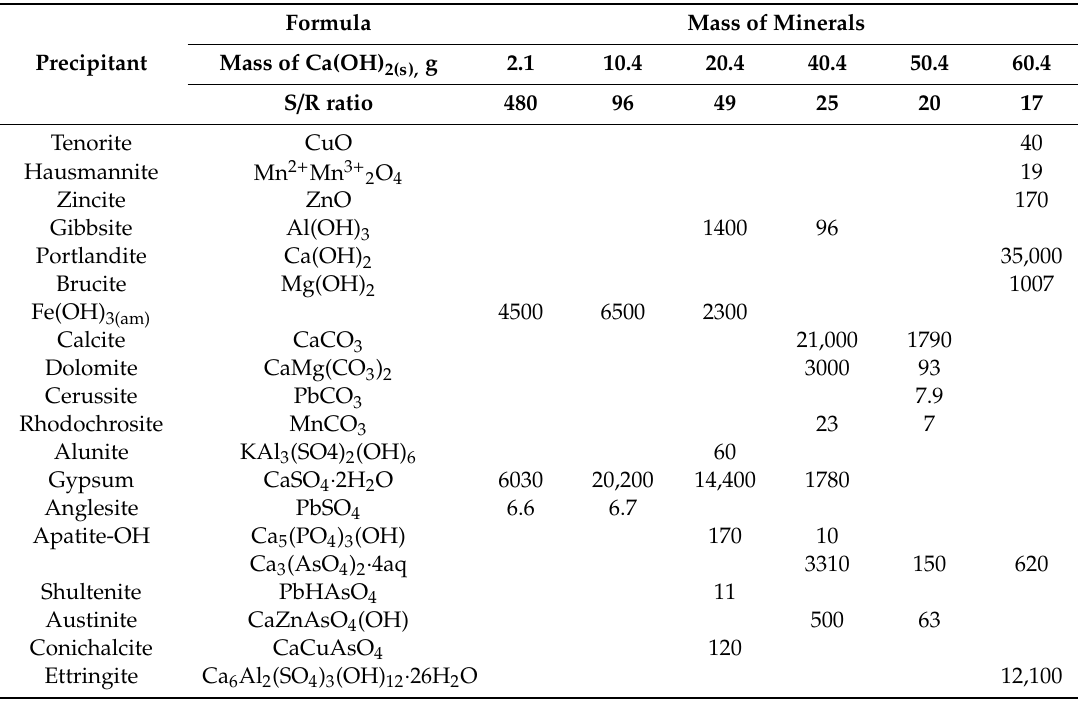
Table 4. Model quantity of precipitated minerals, mg (numerical simulation for Ca(OH) 2 experiments).